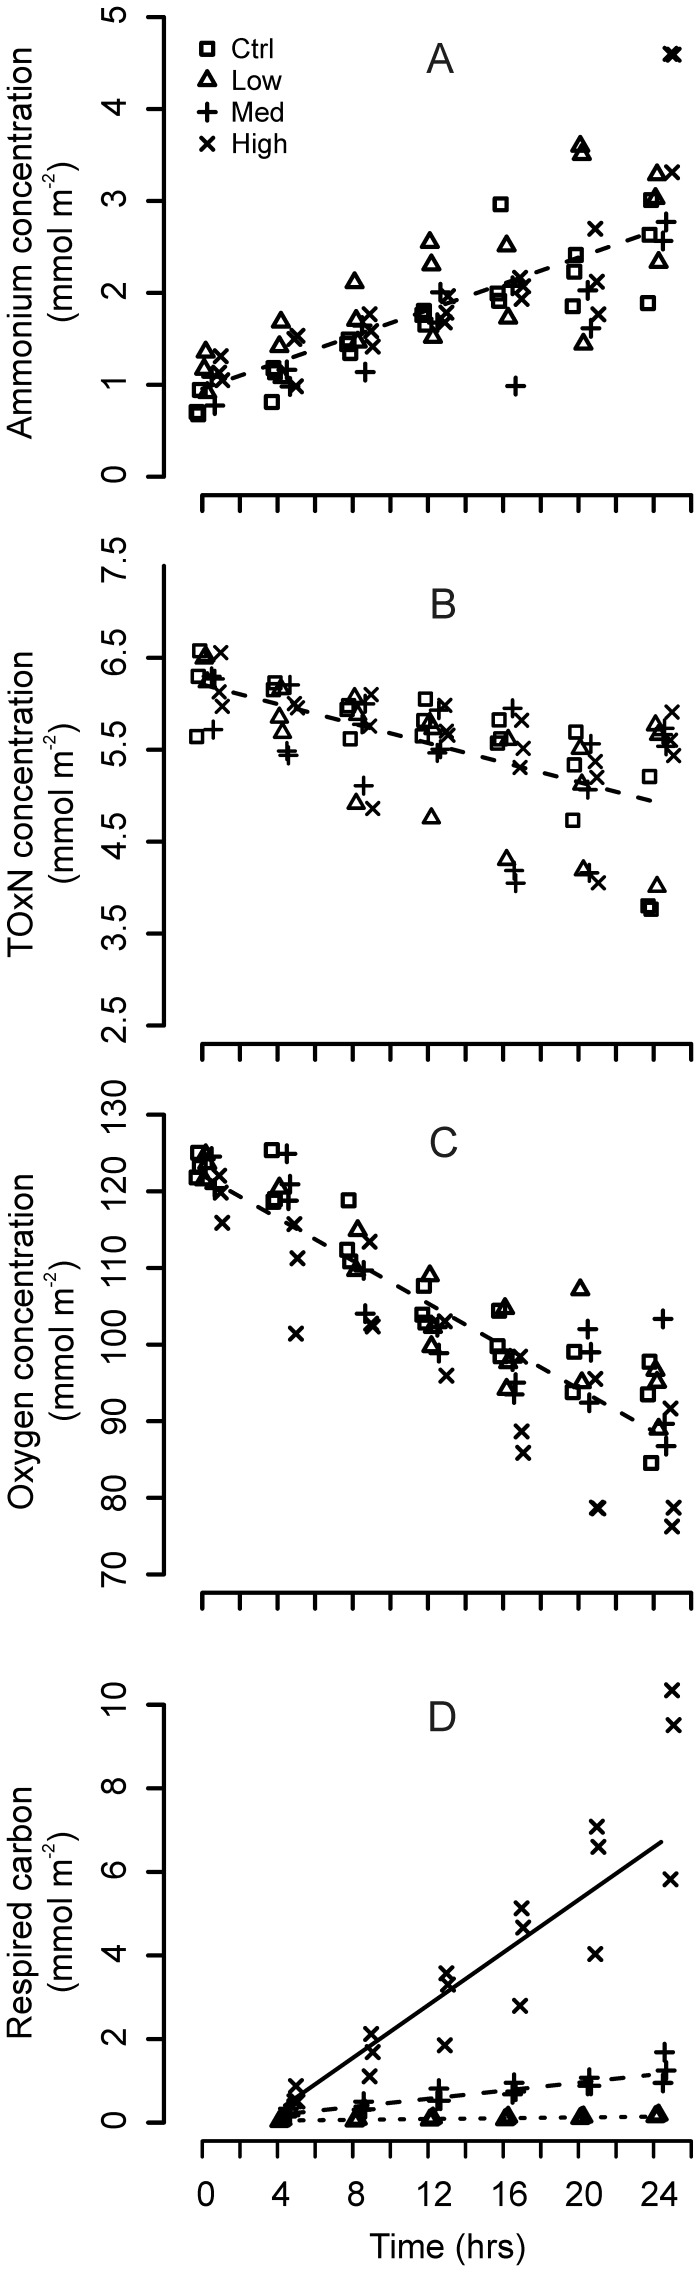
Resource-quantity effects on benthic fluxes.Temporal trends in the concentrations of NH4-N (A), TOx-N (B), oxygen (C) and respired diatom-derived carbon (D). Data from the control, low-, medium- and high-treatments are represented by squares, triangles, vertical- and diagonal crosses respectively.